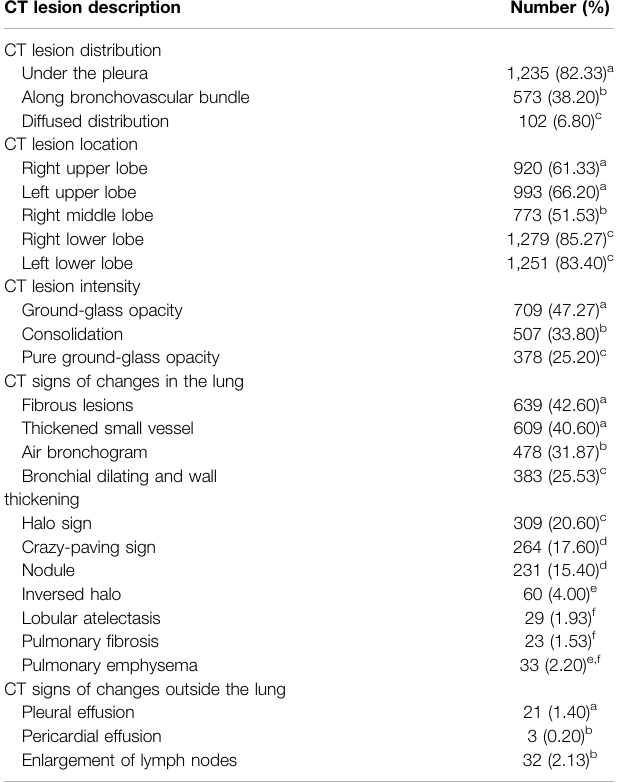
TABLE 1 | The frequency of CT lesion distribution, location, intensity, and